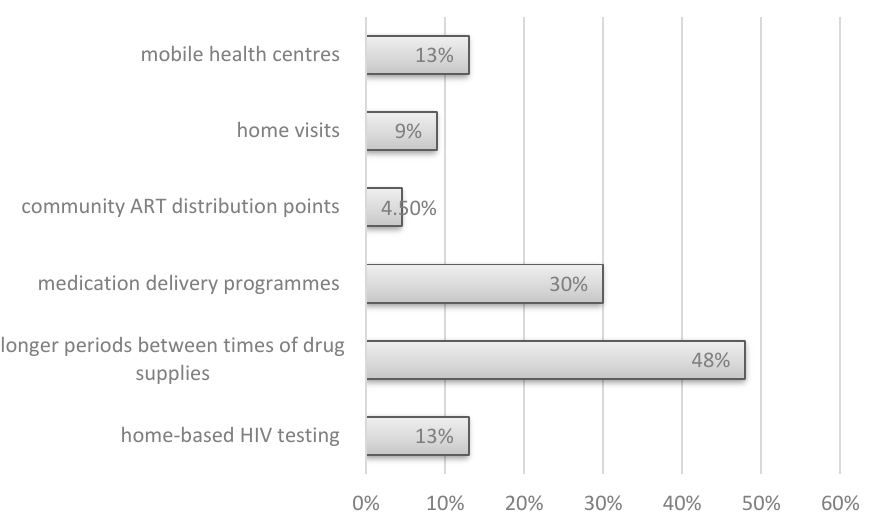
Figure 3. The new tools introduced into HIV medical care after the COVID-19 outbreak.